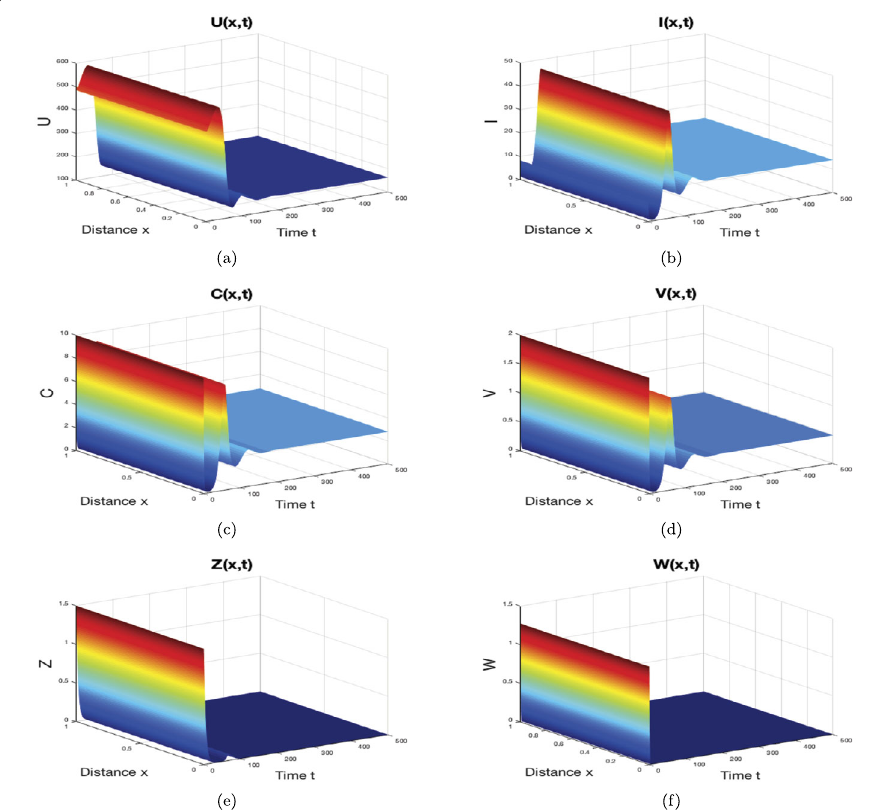
Figure 2 The numerical simulations of system (44)–(46) when R 1 ≤ 1 < R 0 and R 2 ≤ 1 < R 0 . The immune-free equilibrium M 1 is globally asymptotically stable. The sub-figures show the spatiotemporal behaviors of ( a ) uninfected hepatocytes, ( b ) infected hepatocytes, ( c ) capsids, ( d ) viruses, ( e ) CTLs, and ( f ) B cells